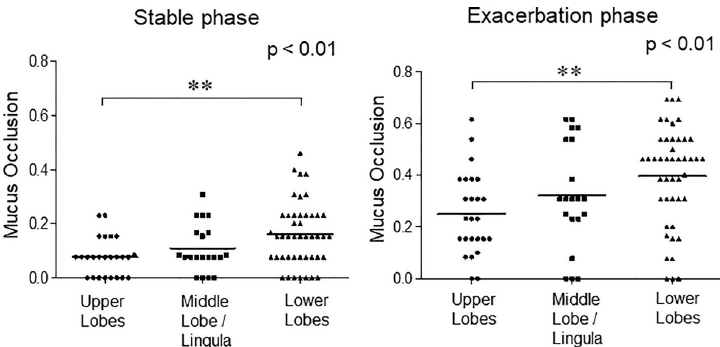
Fig 5. The ratio of mucus-occluded bronchial compartments in 13 subjects during asthma exacerbation and the stable phase observed in the upper, middle/lingula, and lower lobes. Mucus occlusion (mucus plug) was measured by HRCT using curved MPR software. Mucus occlusions were counted per airway generation in all segments of the lung for each subject. Airway segment data were then grouped by lobes for analysis. Each point represents the ratio of mucus-occluded bronchial compartments in 13 patients for each bronchial generation/segment.